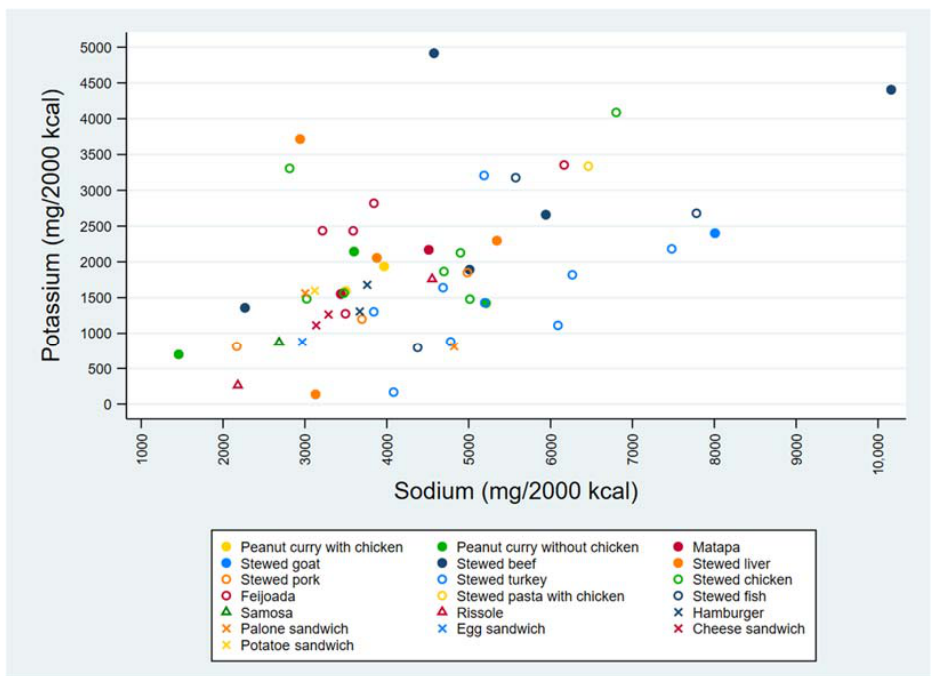
Figure 4. Contents of sodium and potassium (mg/2000 kcal) of all food samples collected ( n = 56), distributed in three food groups: main dishes ( ● ○ ), fried snacks ( ∆ ) and sandwiches (x).